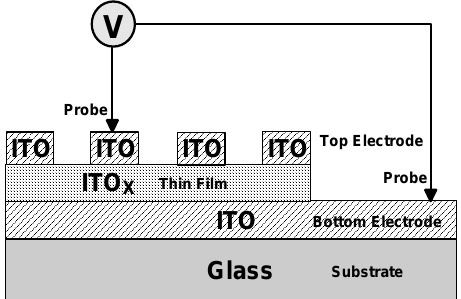
Figure 1. The MIM structure of the transparent ITO/ITO X /ITO RRAM